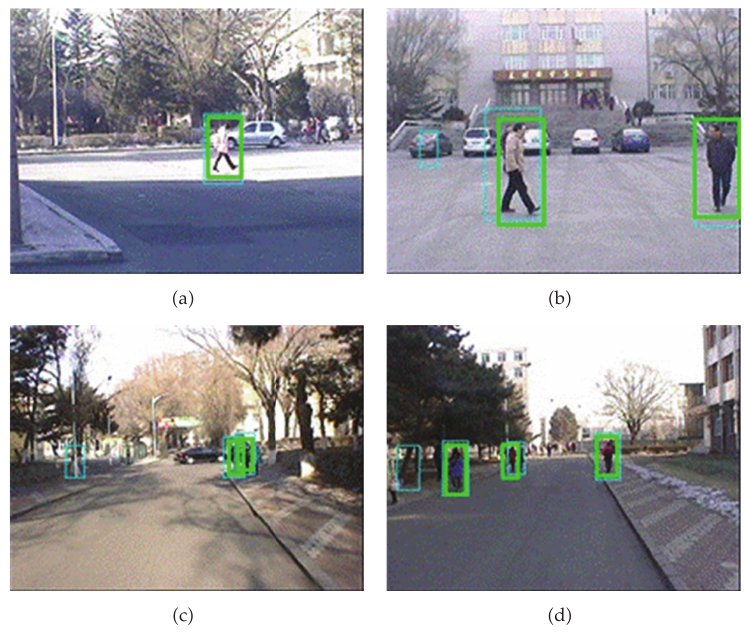
Figure 12: Pedestrian recognition based on multisensor